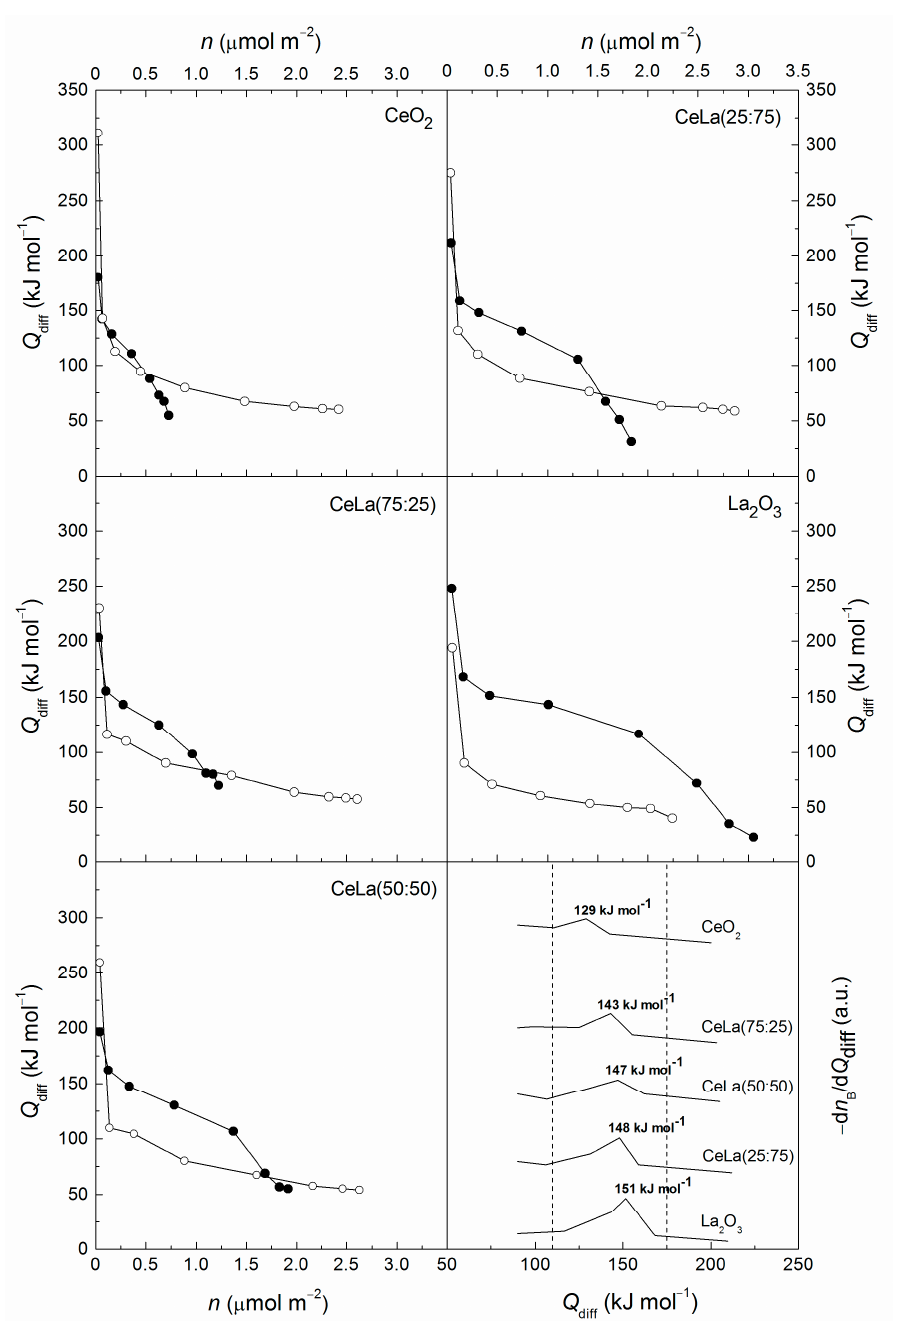
Figure 5. Differential heats of adsorption vs. probe molecule uptake and basic site energy distribution plots: ( ● ) carbon dioxide; ( ○ ) ammonia.